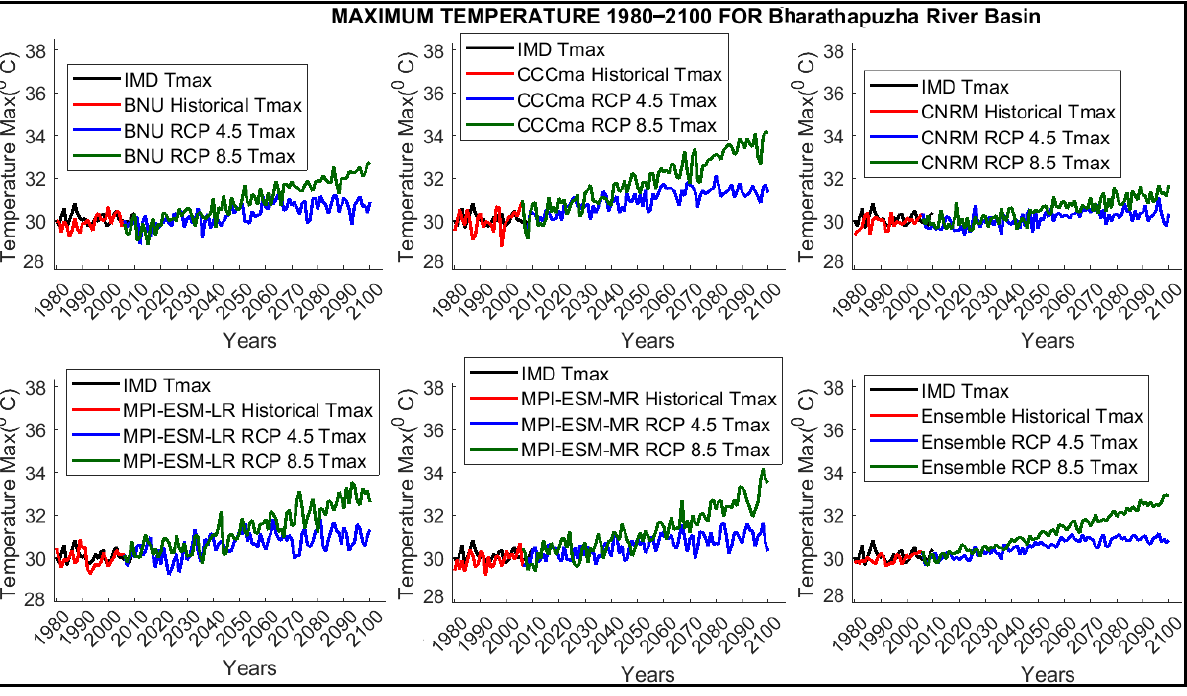
Figure 7. Comparison of observed and GCMs simulated minimum temperature during historical (1981 to 2010) and future periods (2011 to 2100). 3.2. Calibration and Validation of the SWAT Model SWAT simulation in the current study was conducted on a monthly scale. The topog- raphy (DEM) was used for the delineation of the basin into several sub-basins. The auto- matic watershed delineation tool of ArcGIS calculates the stream densities and divides the area based on topographical characteristics. The number of sub-basins resulting from the automatic delineation was adjusted by adding/deleting the outlets to adequately delineate the watershed for the hydrologic simulation [64]. The model was first run using a five- year warm-up period, from 1986 to 1990. Table 4 lists the sensitive parameters, with the minimum, maximum, and fitted values used for calibration.